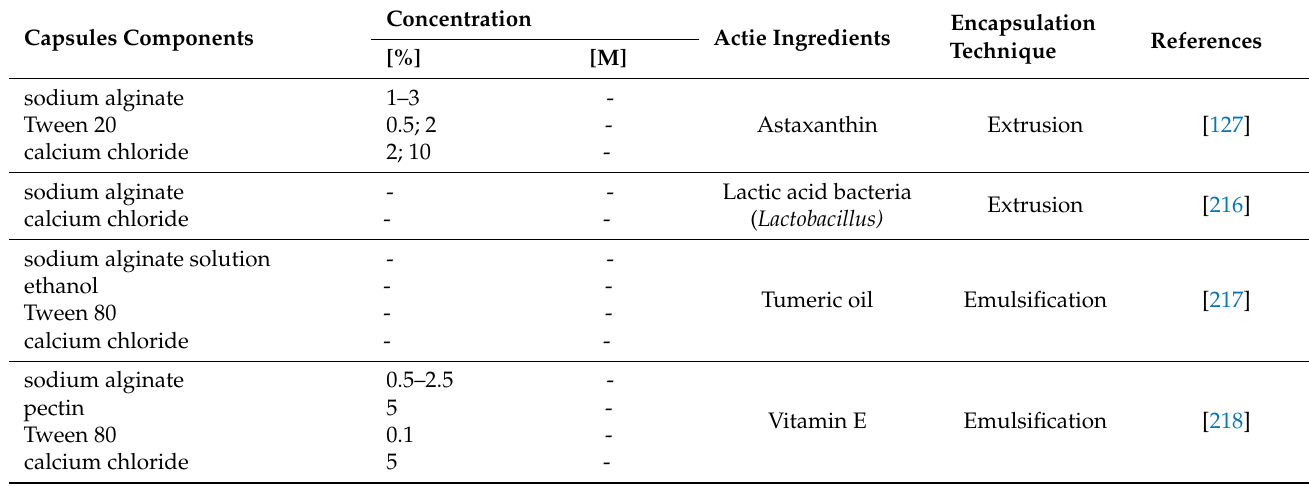
Table 5. The application of alginate carriers in the cosmetic